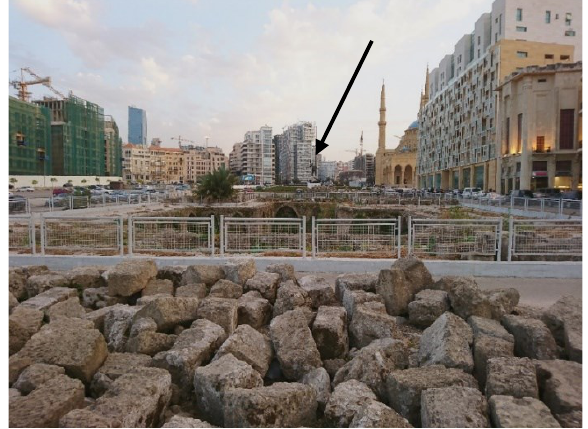
Figure 6. The Martyrs’ Square (with the Martyrs’ statue where indicated) and Roman ruins, Downtown, Beirut (adapted from Maria A. El Helou photo archive)